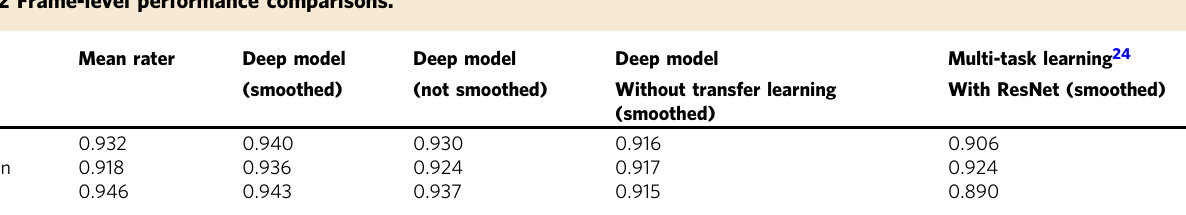
Table 2 Frame-level performance comparisons.